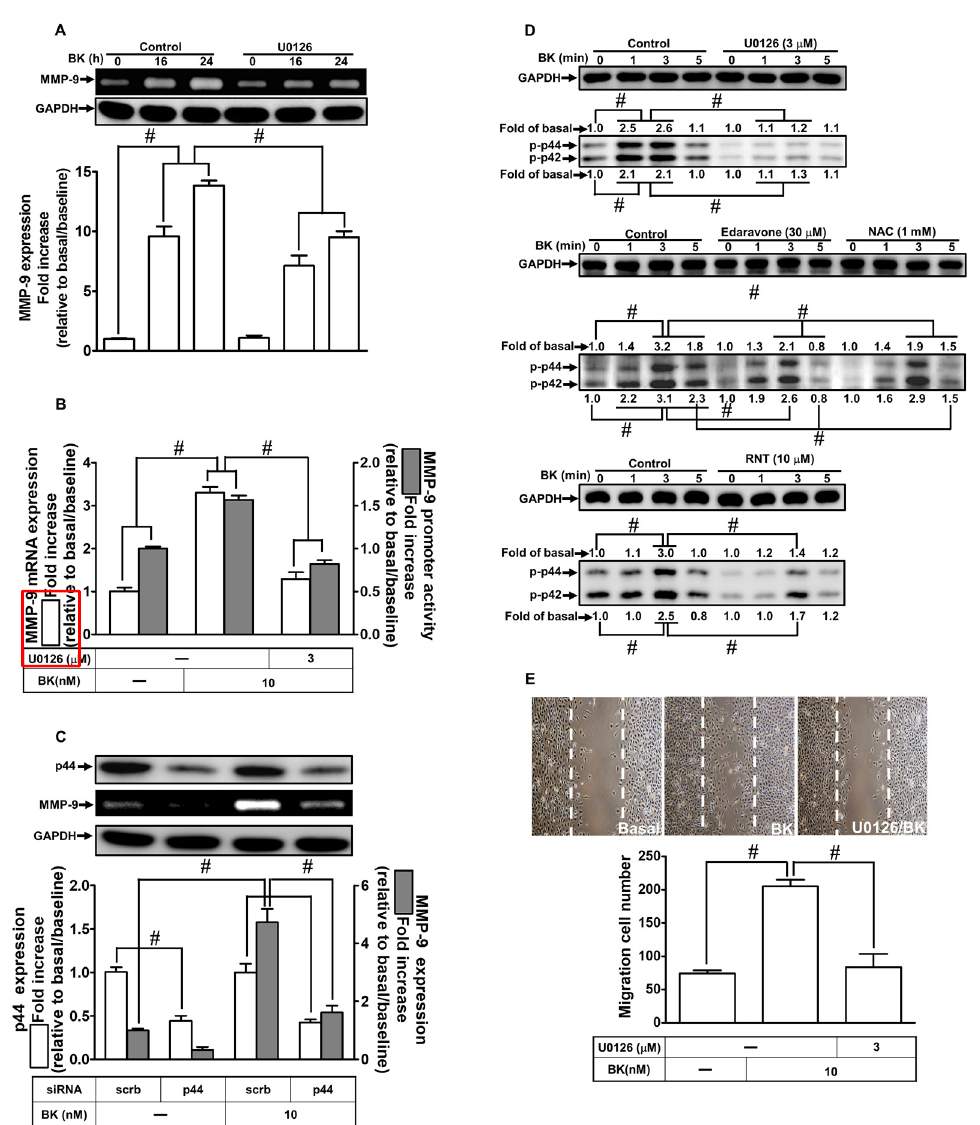
Figure 5. RNT attenuates p44/p42 activity induced by BK in RBA-1 cells. ( A ) Cells were pretreated with 3 μ M U0126 for 1 h and then stimulated with BK (10 nM) for 16 and 24 h. The levels of MMP-9 in the media and GAPDH in cell lysates were examined by gelatin zymography and Western blot,